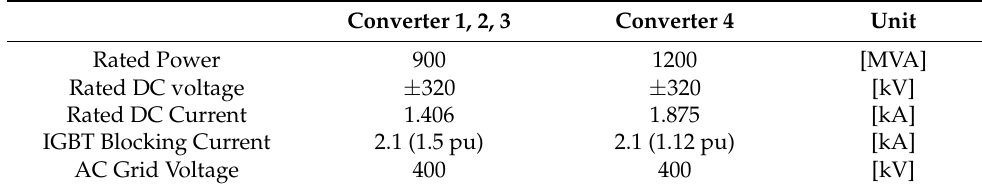
Table 3. HVDC grid parameters.